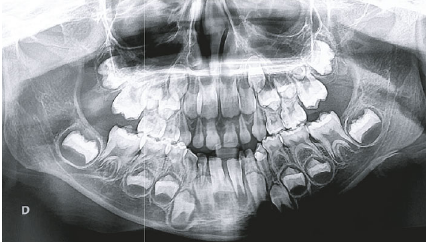
Figure 9: Panoramic radiograph showing the absence of dental abnormalities in the permanent teeth.